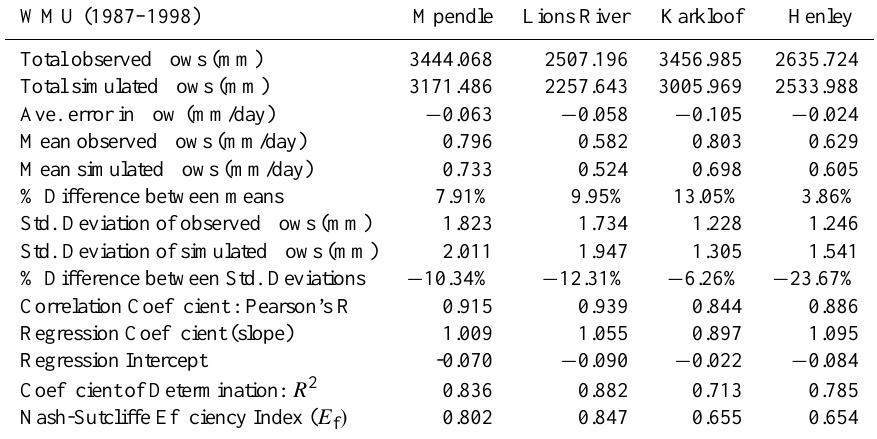
Table 6. Statistics of performance of the ACRU model Mgeni Catchment: comparison of Daily Observed and Simulated